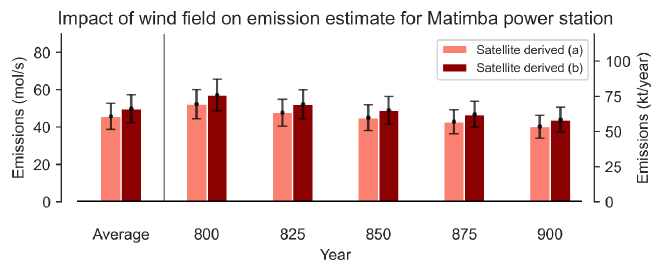
Figure A4. Demonstration of the influence that the chosen wind product has on the final emission estimate using data for the entire 2018– 2021 period from Matimba power